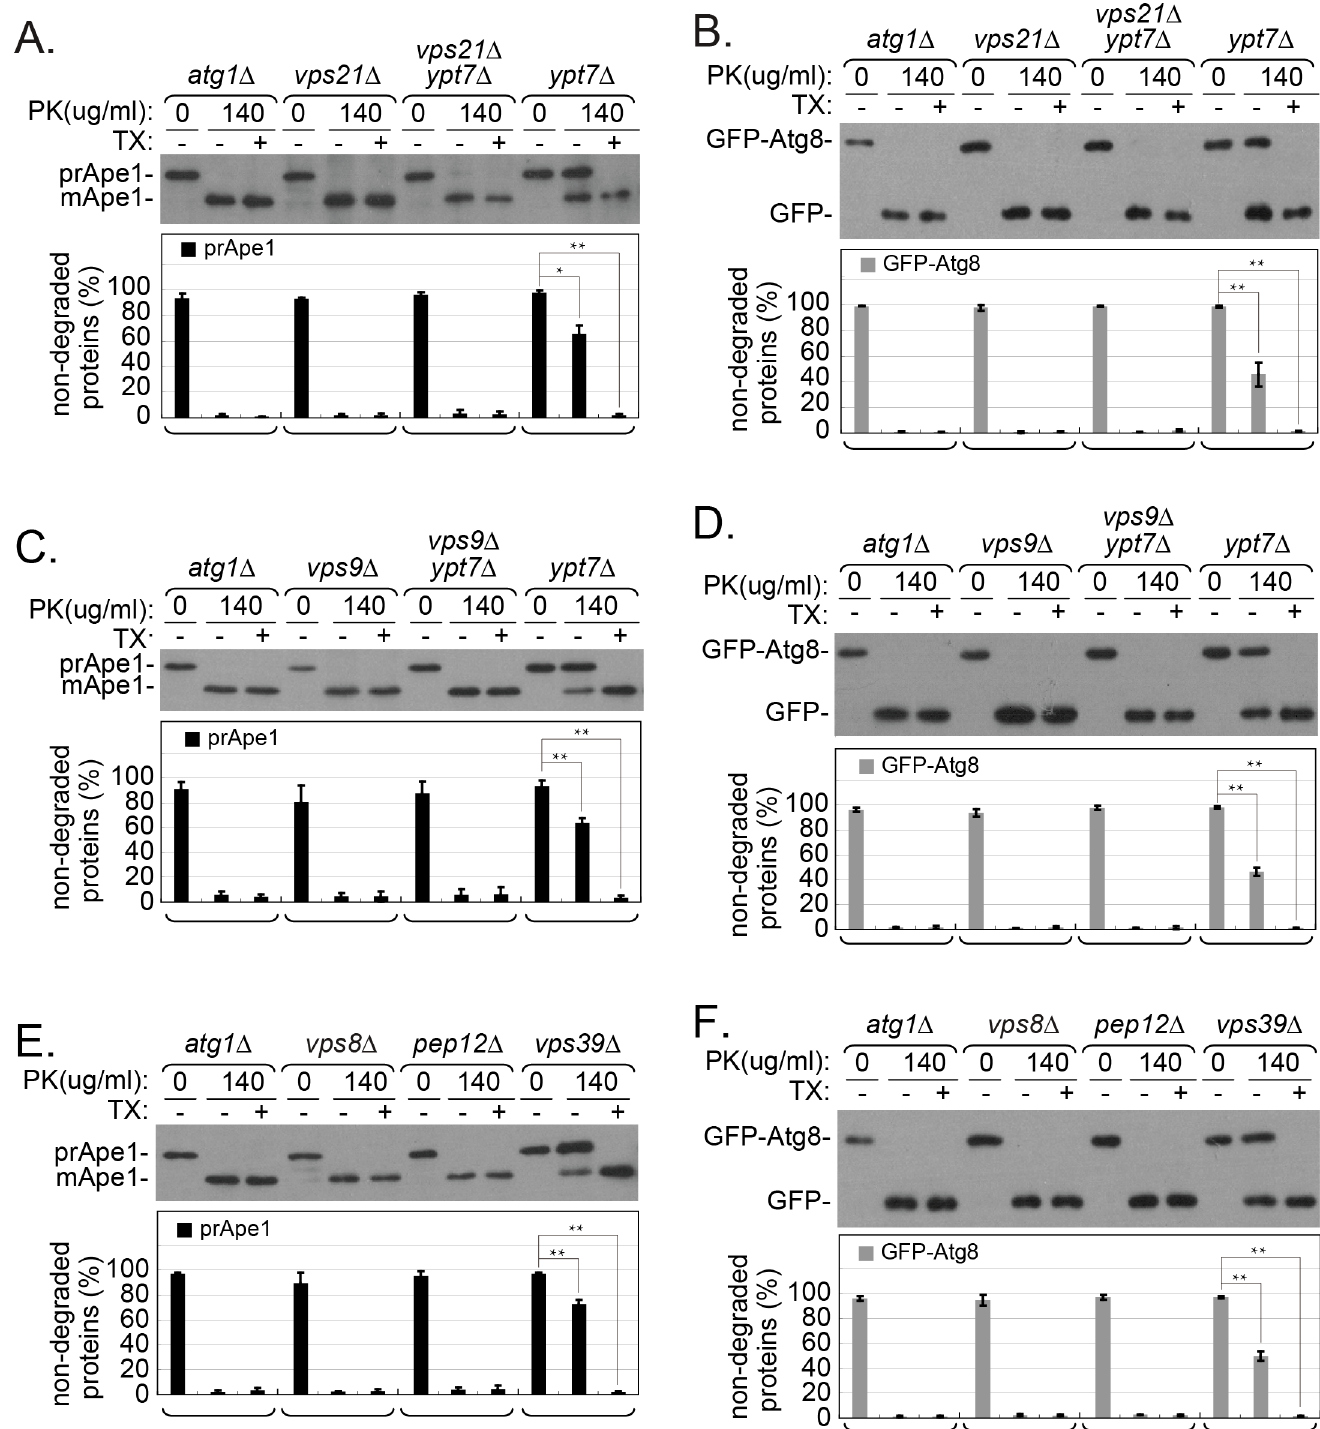
Fig 2. prApe1 and GFP-Atg8 are not protected from proteolysis in APs isolated from cells defective in the Vps21 module function. Protease- protection assays were performed using pellet (P5) fractions preparedfrom cell lysates of the indicatedstrains using immunoblot analysis. A-B. prApe1 (A) and GFP-Atg8 (B) are protectedfrom degradationin ypt7 Δ , but not in vps21 Δ or vps21 Δ ypt7 Δ mutant cells. C-D. prApe1 (C) and GFP-Atg8 (D) are protectedfrom degradation in ypt7 Δ , but not in vps9 Δ or vps9 Δ ypt7 Δ mutant cells. E-F. prApe1 (E) and GFP-Atg8 (F) are protectedfrom degradationin vps39 Δ ,but not in vps8 Δ or pep12 Δ mutant cells. Cells expressingGFP-Atg8 from the chromosome were grown in rich medium and shifted to nitrogen- starvation medium (as in Fig 1). The P5 fractions of the cell lysates (see Materials and Methods) were treated with proteinaseK (PK) with or without